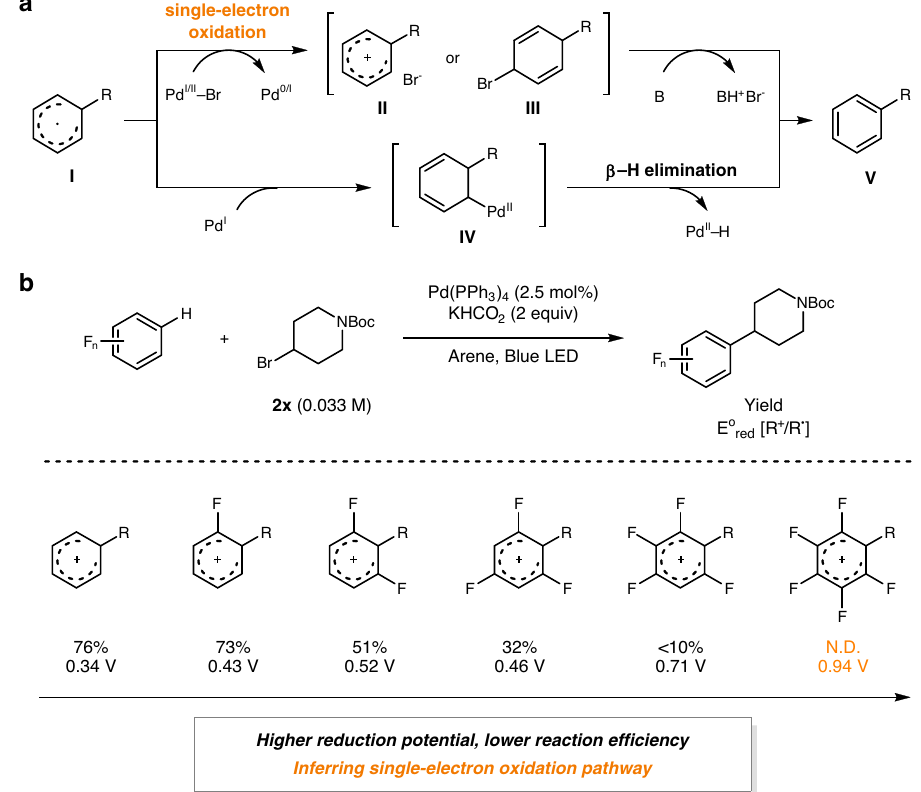
Fig. 3 Investigation on the catalytic turnover process. a Two possible catalytic turnover processes. b Reactivity difference among poly fl